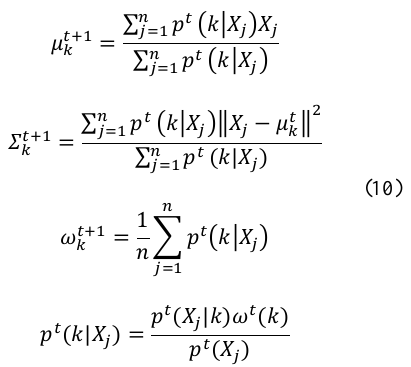
Figure 3. Flowchart of the GWMI registration